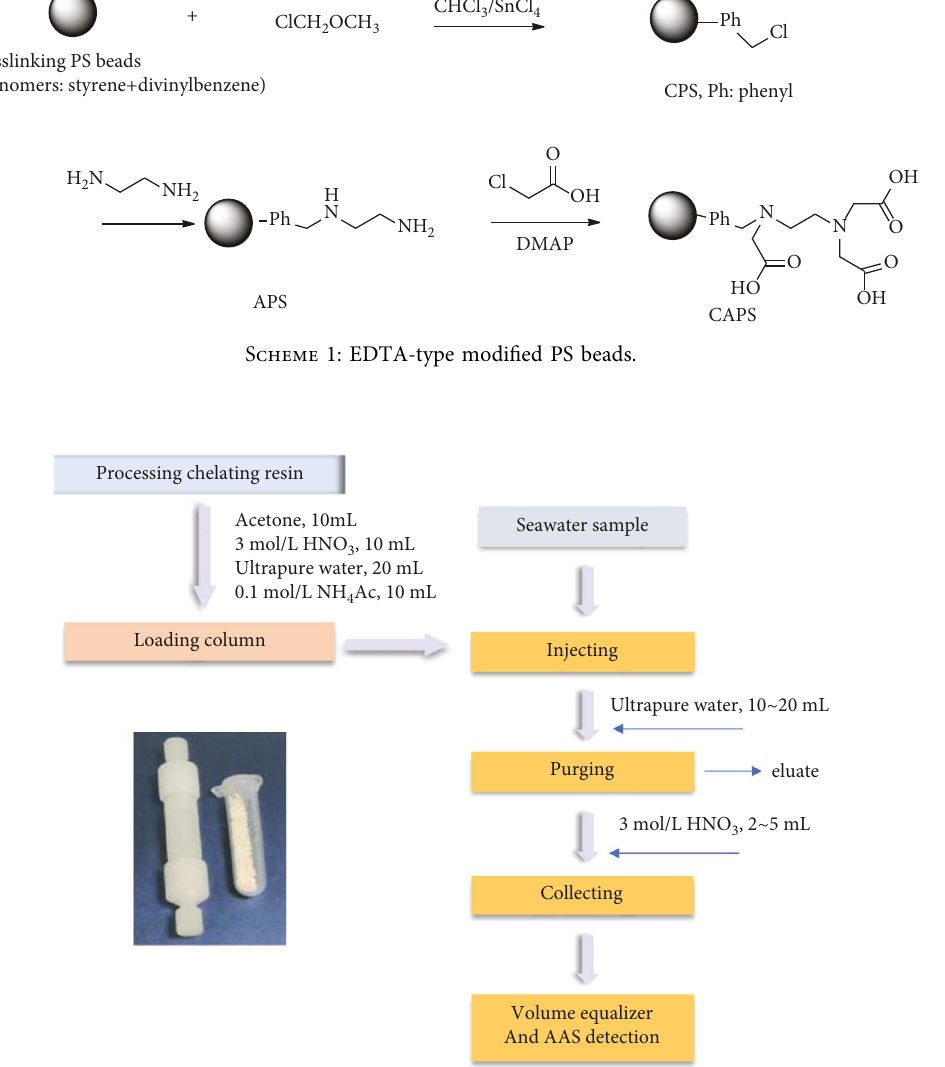
Figure 1: The process of trace metal ion preconcentration. Insert: the preconcentration column and filling resin, as-prepared EDTA-type